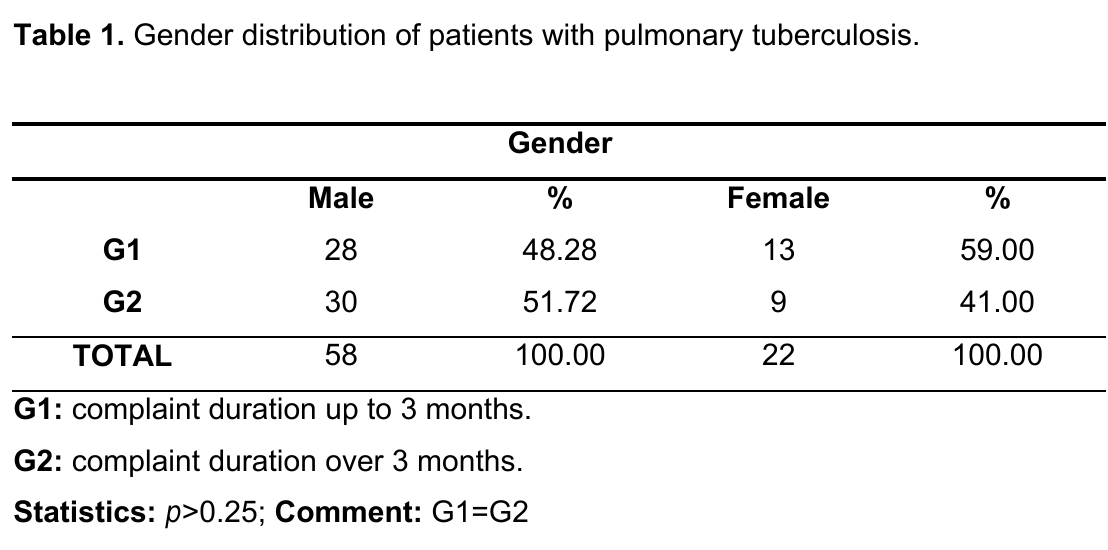
Table 2. Bacilloscopy